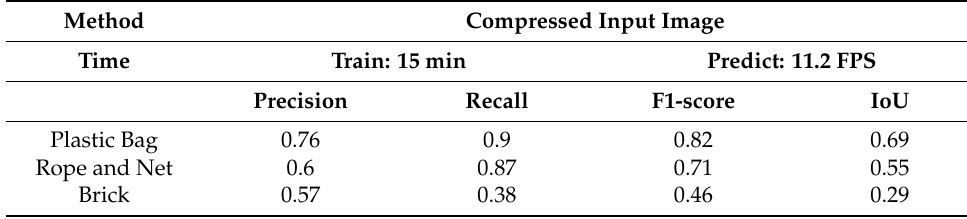
Table 5. Results of compressed input images.